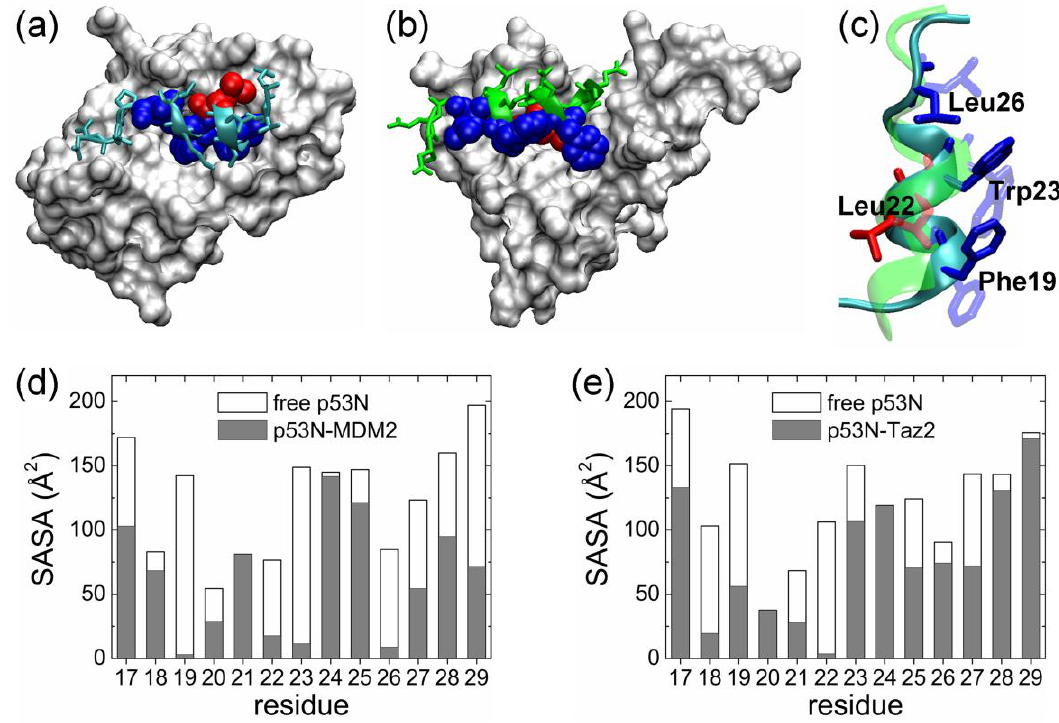
Figure 1. The analysis of the structures of p53N when bound to different